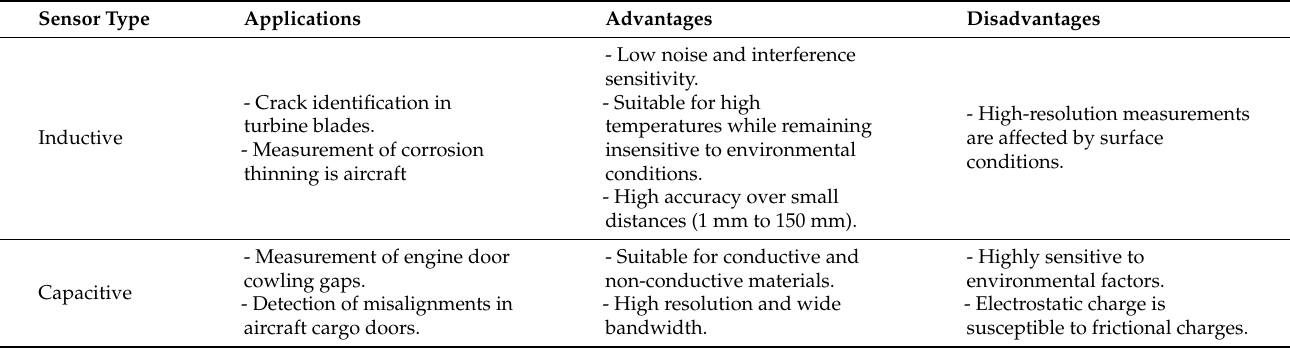
Table 18. Displacement